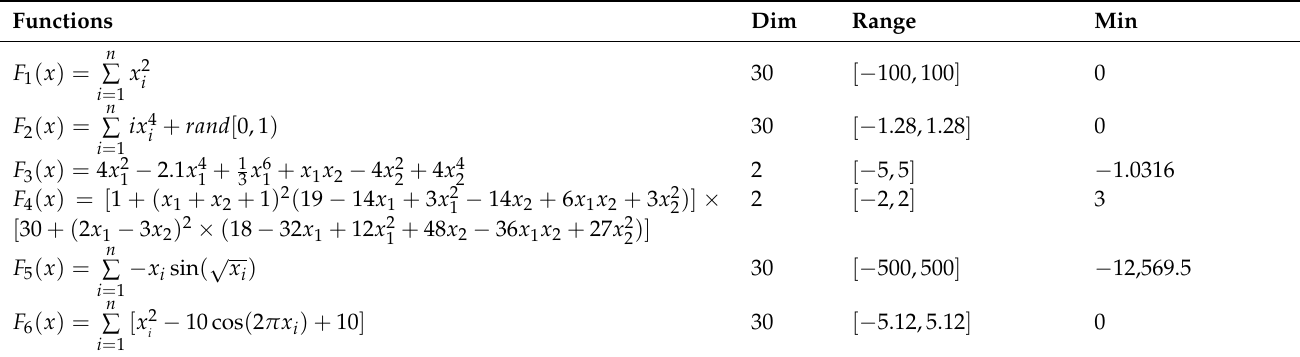
Table 3. Details of the test functions.